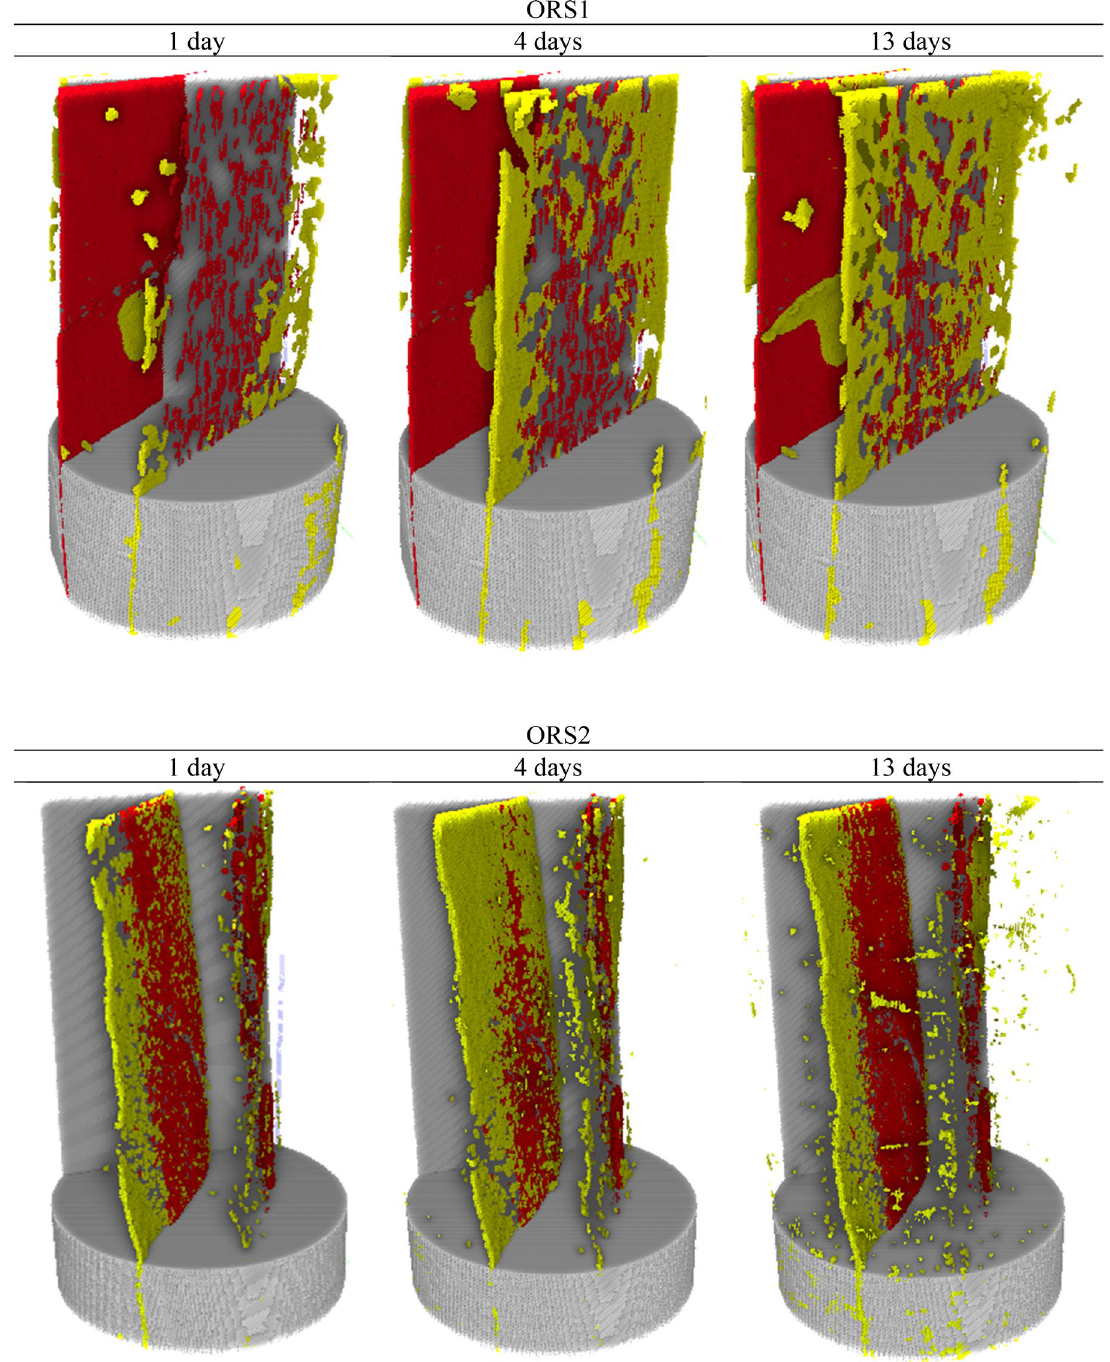
Figure 7. Segmented internal structure of ORS1 (top) and ORS2 (bottom) showing empty plus water/oil filled fracture space (red) and water/oil diffusion into matrix (yellow) at 1 day, 4 days, and 13 days. The red colour represents fracture space plus the fluids residing therein, and the yellow colour represents the fluids diffused into the matrix adjacent to the